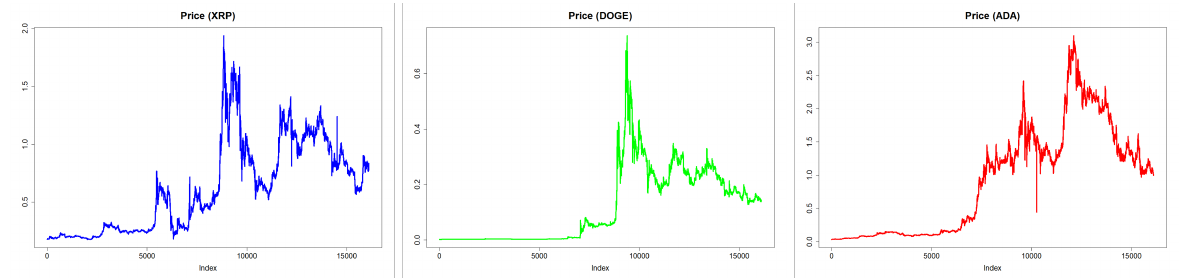
Figure 3. Hourly adjusted closing prices of cryptocurrencies (Group 2).